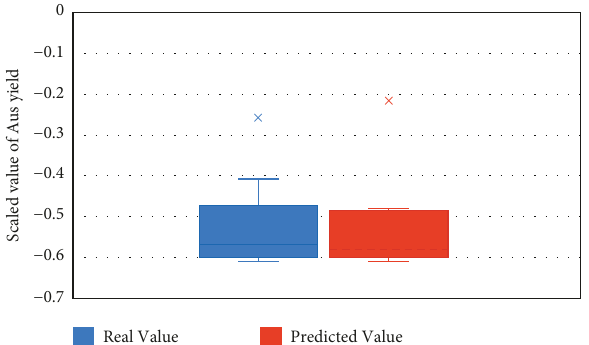
Figure 10: Comparison between real values and predicted values of Aus yield for XGBoost using box